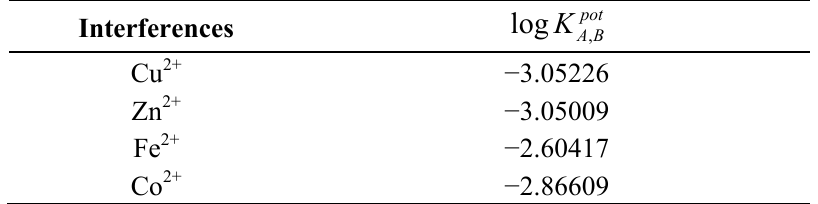
Table 2. The summary of calculated selective coefficient values.